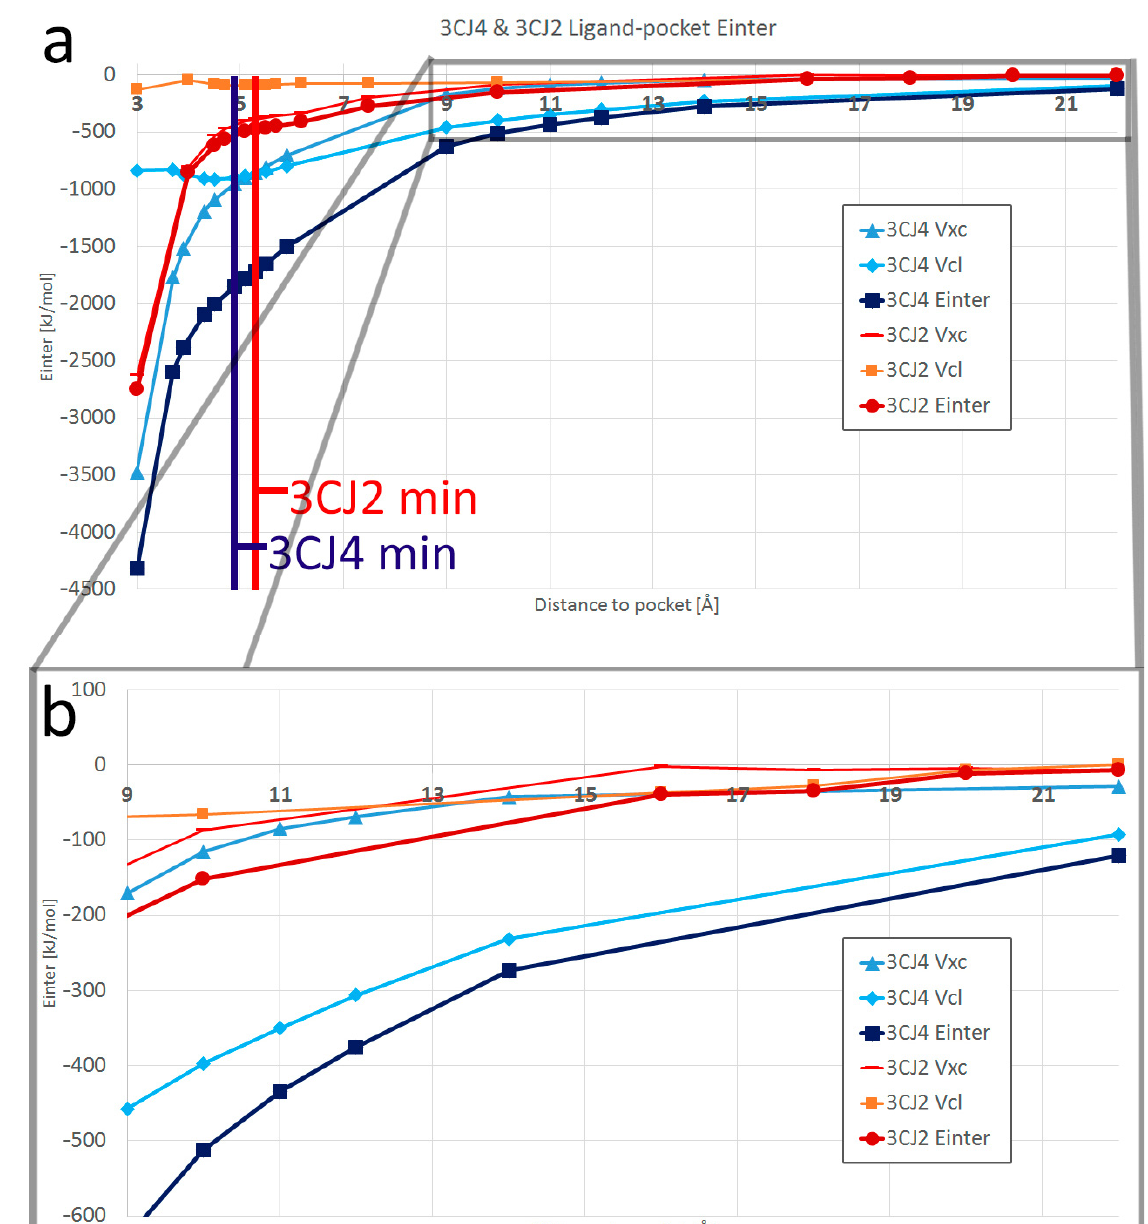
Figure 8. E inter progression between the ligand and pocket of the studied systems using interacting quantum fragments (IQF). In the top graph ( a ) the full progression is shown, and at short range, the V xc component dominates the interaction. This preponderance lasts practically until the distance reaches the global minimum for the more polar 3CJ4 system, but in the case of 3CJ2, the interaction has a mainly covalent character for longer, until a separation of 10.5 Å, well into the distances of segment 3. The global minimum distances for both systems are shown as vertical lines (shades of blue for 3CJ4 and shades of red for 3CJ2). In ( b ), an enlarged version of the interactions at the longer distances between the ligand and the pocket indicate an increased relevance of the classical electrostatics component of the interaction ( V cl ).